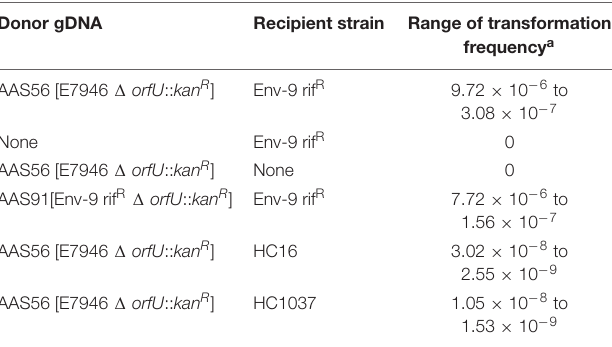
TABLE 2 | Transformation of Vibrio cholerae Env-9 rif R (AAS35) strain with genomic DNA (gDNA) of donor V. cholerae strains with chitin induction. Donor